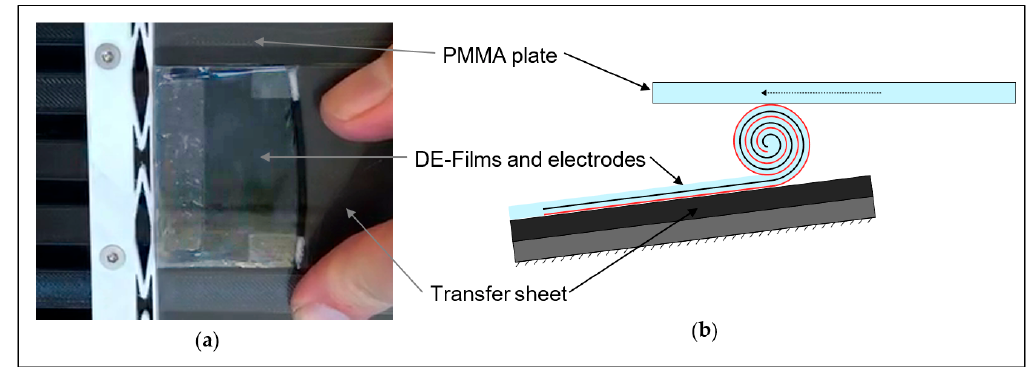
Figure 6. Picture ( a ) and schematic ( b ) of the new rolling process. It can be noted that the absence of a hollow core maximizes the volume utilized by the DE.